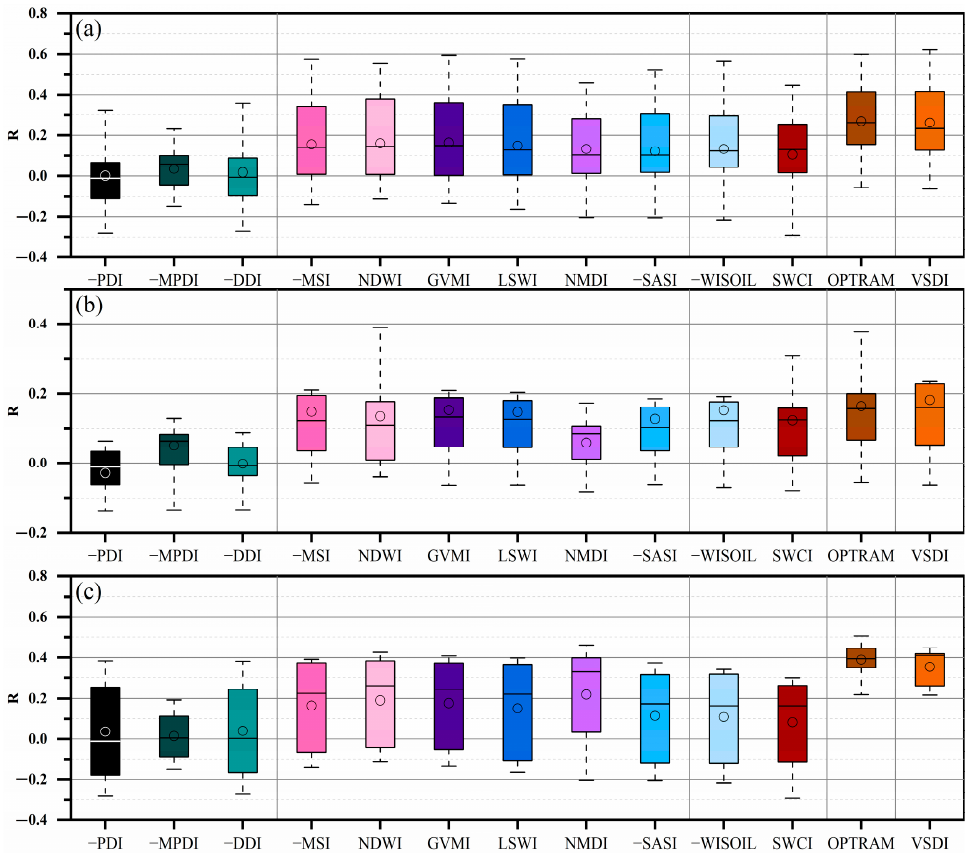
Figure 5. Box plots of Pearson’s R between the in situ observed SM and the optical SM indexes during the whole study period in ( a ) all experiments, ( b ) SMAPVEX12 experiment, and ( c ) SMAPVEX16 Manitoba experiment.